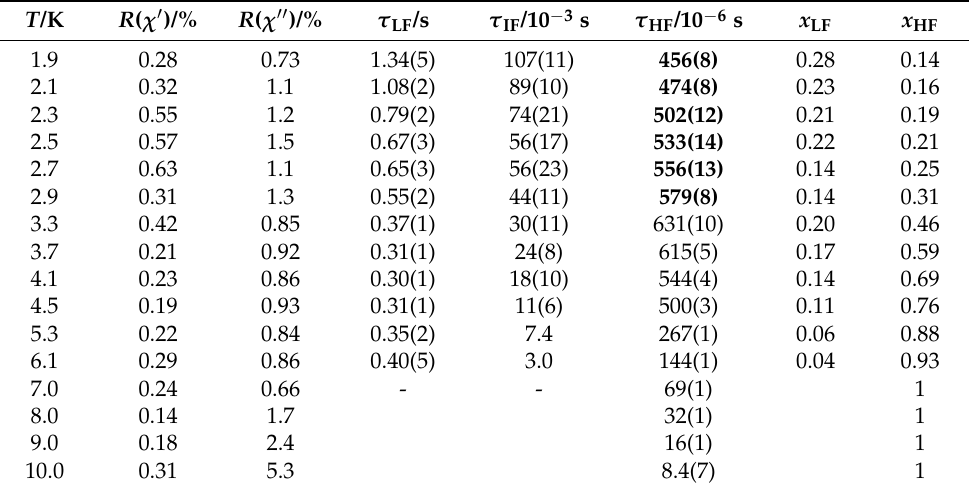
Figure 10. AC susceptibility and relaxation times for 2 . Full lines—fitted. Hydrogen atoms are omitted hereafter. ( a ) Left— full scale of data taking, right—zoomed high-frequency range truncated for clarity. ( b ) Arrhenius-like plot, ( c ) log-log plot, ( d ) relaxation time vs. temperature (inset includes the standard deviations as error bars). Data adapted from ref. [26]. 2018, American Chemical Society. Table 5. Fitted parameters of the three-set Debye model for 2 at B DC = 0.4 T including the discrepancy factors and standard